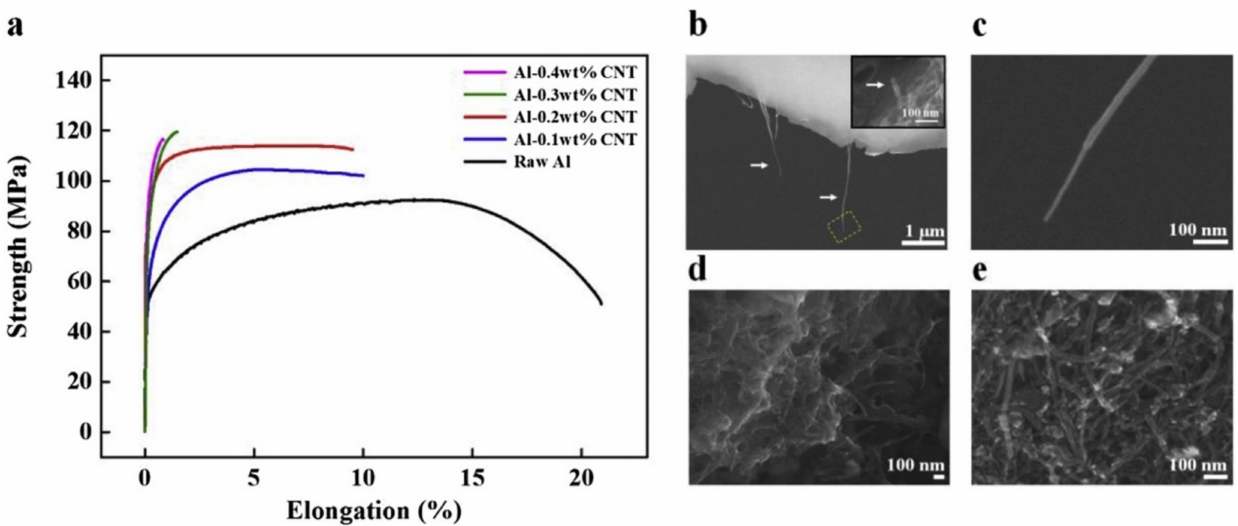
Figure 4. ( a ) Tensile test curves from extruded raw Al and Al/CNT composites and SEM images of ( b ) the fracture surface of the Al-0.2 wt.% CNT composite after tensile testing, showing some pulled out and fractured CNTs. ( c ) High magnification of pulled out CNTs, ( d ) the CNT cluster in the fracture surface of the Al/0.3 wt.% CNT composite after tensile testing. ( e ) The remaining CNTs after etching away the Al in an acidic solution and filtering. Reproduced from [68] with permission from Elsevier,